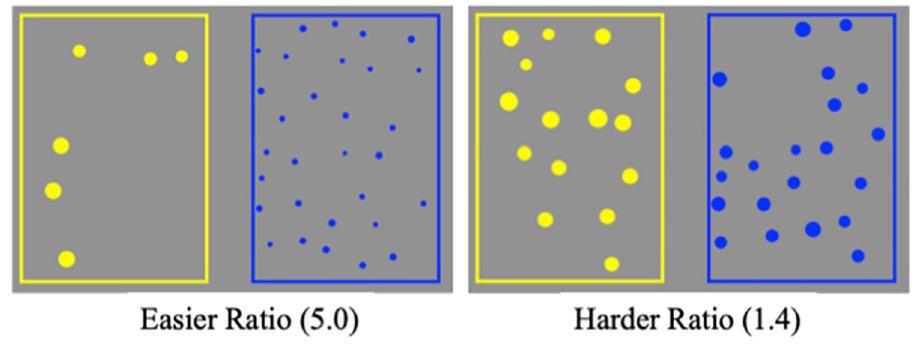
Fig 1. Approximate Number System (ANS) trial